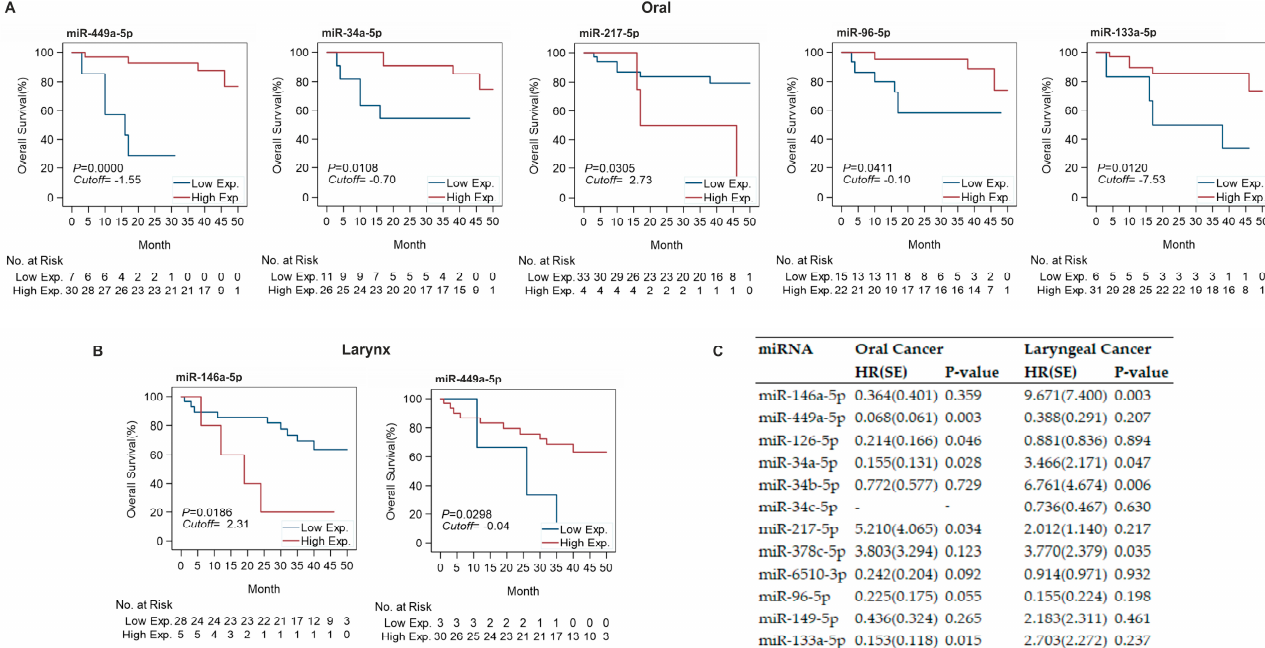
Figure 5. Relation between miRNA expression and overall survival. ( A , B ) Kaplan Meier survival curves showing comparison of overall survival between low and high miRNA expression defined by optimal cutoff of −∆∆ Ct in oral ( A ) and laryngeal ( B ) cancers. ( C ) Summary of multiple Cox regression analysis for oral and laryngeal cancer investigating hazard ratio (HR) of high expression vs. low expression of each miRNA in separate survival models with age at diagnosis, T staging and N staging under control. HR < 1 denotes high miRNA expression at lower risk compared to low expression. HR > 1 denotes high miRNA expression at higher risk than low expression.